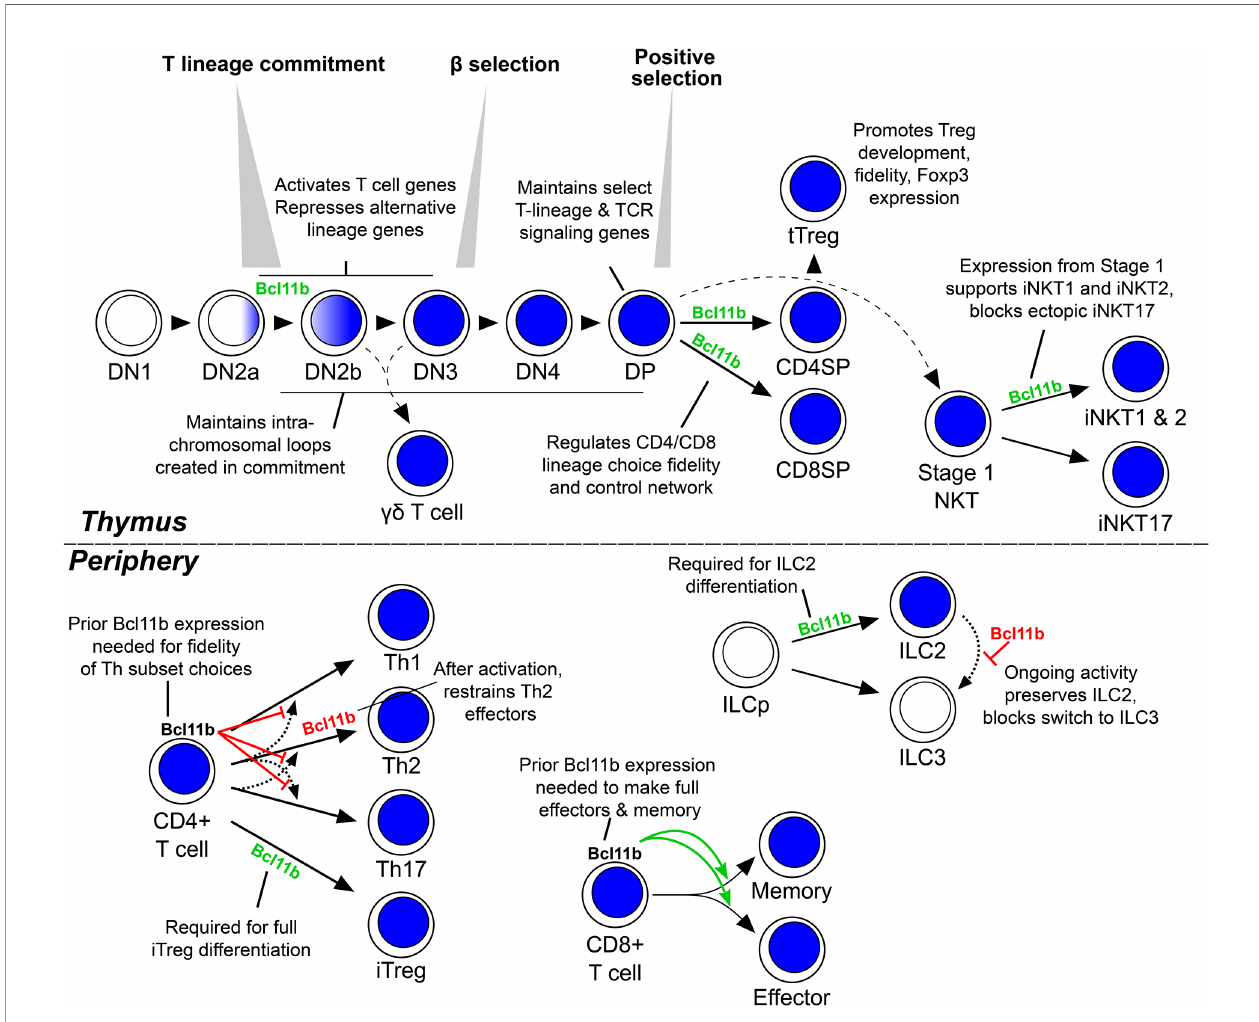
FIGURE 2 | Roles of Bcl11b through lymphocyte development and differentiation. Schematic showing the developmental relationships of various lymphocyte lineages. Blue shading indicates Bcl11b-expressing developmental stages. Green text and arrows indicate supportive roles of Bcl11b is the indicated process, red text and fl at arrows indicate an inhibitory role. Not shown is the NK-like population that the various DN2b-onward thymic stages may differentiate into following Bcl11b removal. DN, double negative; DP, double positive; SP, single positive; tTreg, thymic regulatory T cell; iNKT, invariant natural killer T cell; Th, helper T cell; iTreg, inducible regulatory T cell; ILC, innate lymphoid cell; ILCp, ILC